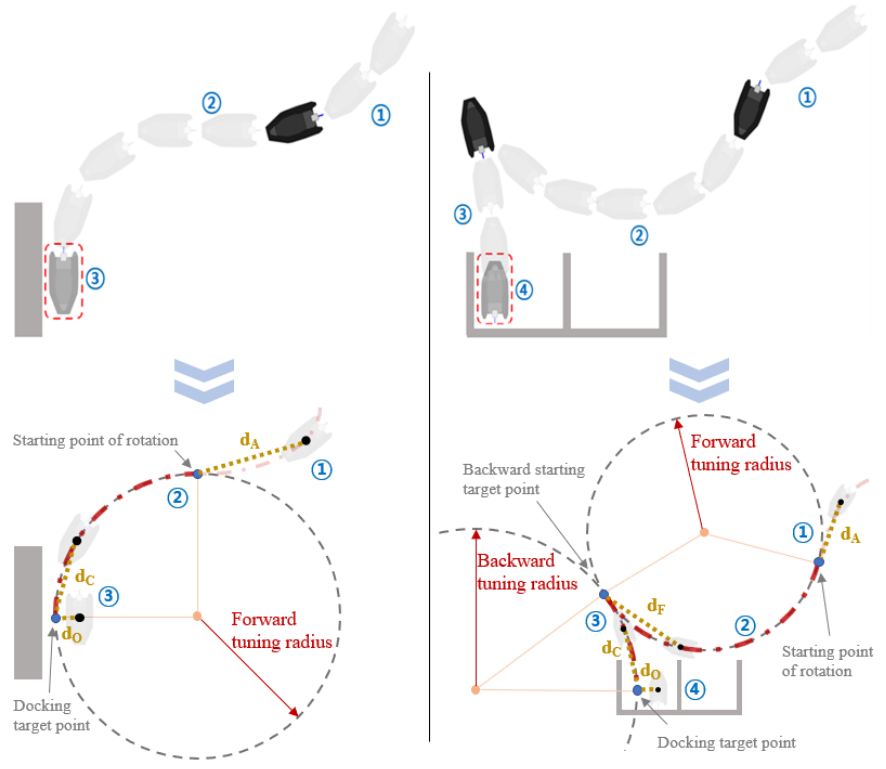
Figure 2. Definition of the parallel/finger-type path-planning method and the schematic of the berthing process.